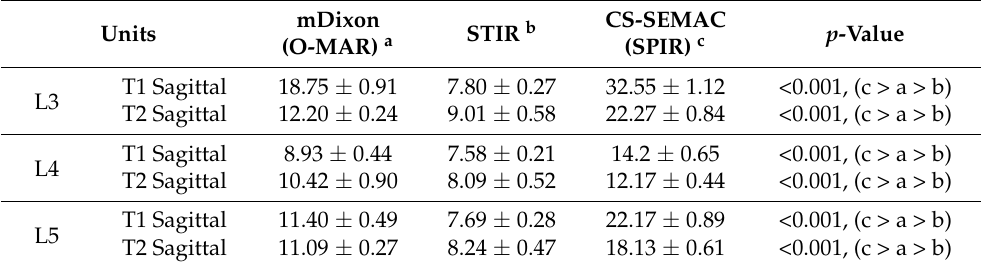
Table 4. SNR result of T1, T2 MAR effect in testing transplant